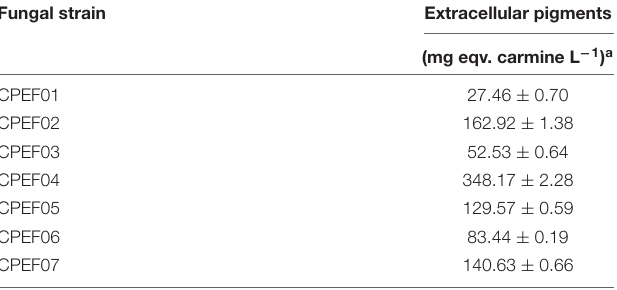
TABLE 1 | Extracellular pigment production by seven endophytic fungi isolated from the roots of Avicennia marina . Fungal strain Extracellular pigments